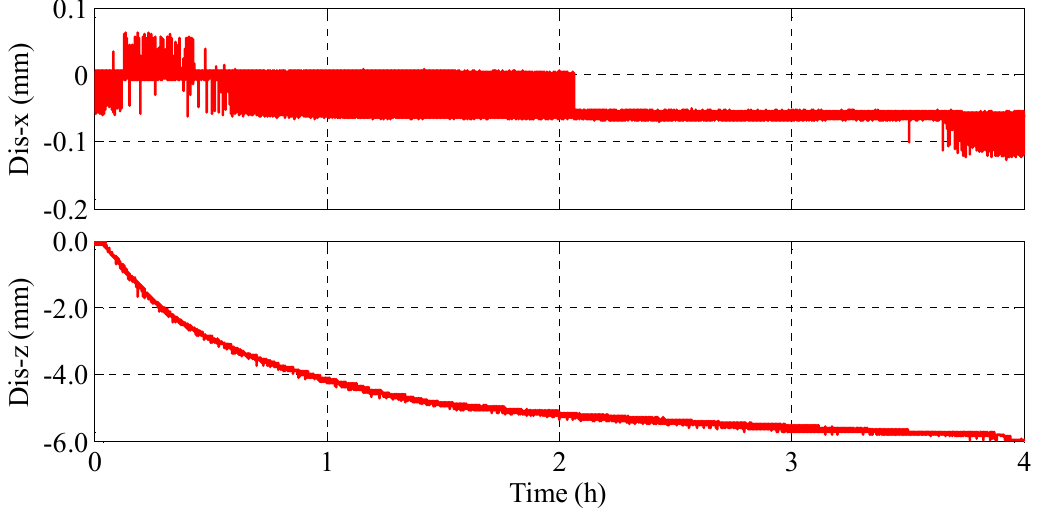
Figure 6. Time history of the horizontal and vertical displacement of structure B recorded in Test 3.